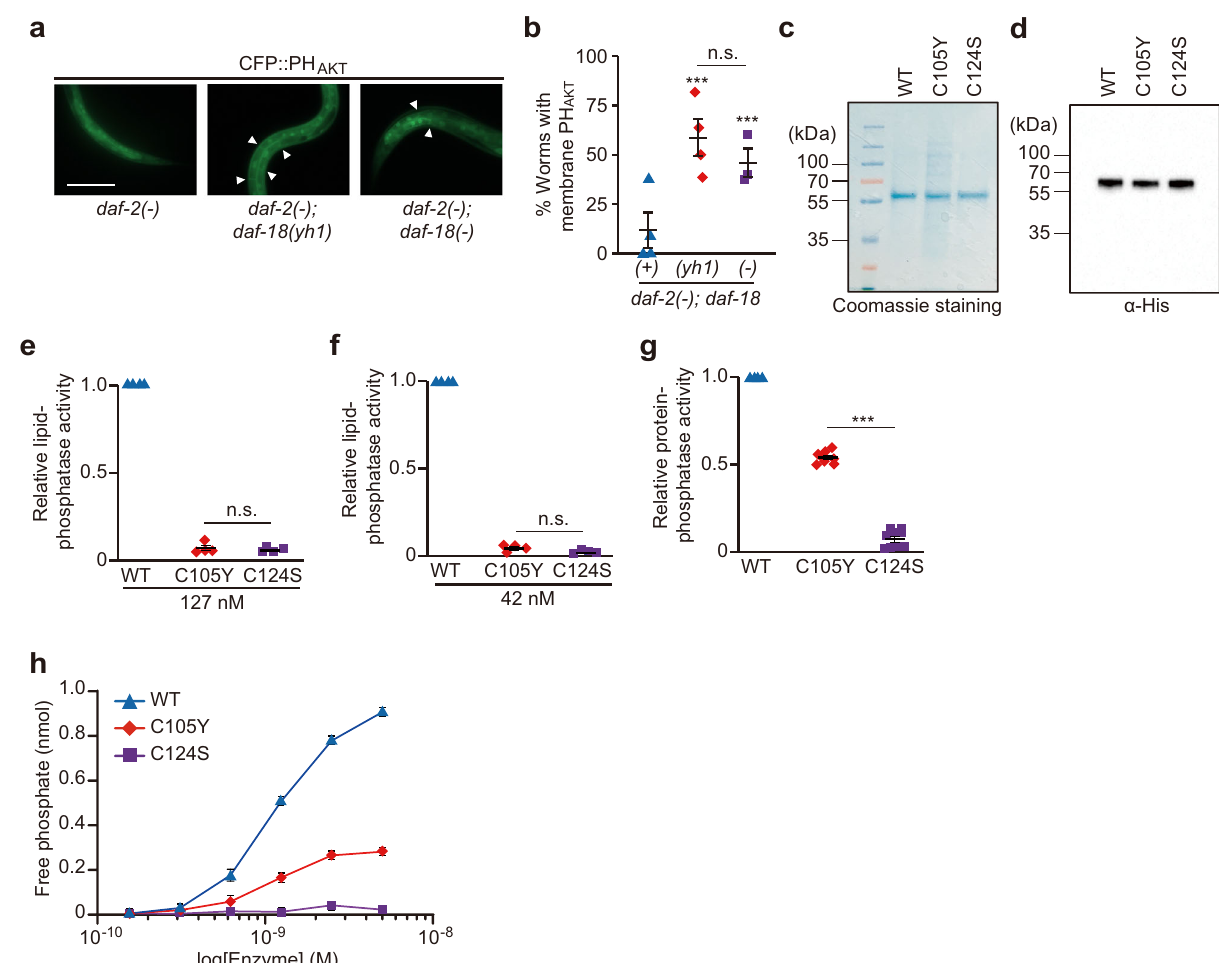
Fig. 3 daf-18(yh1) substantially decreases lipid phosphatase activity, but partially maintains protein phosphatase activity of DAF-18/PTEN. a Representative images of rpl-28p::CFP::PH AKT -expressing worms with daf-2(e1370) [ daf-2( − ) ], daf-2( − ); daf-18(yh1) , or daf-2( − ); daf-18(nr2037) [ daf- 18( − ) ] mutations ( rpl-28p : a promoter of a ubiquitous rpl-28 , ribosomal protein large subunit 28). Scale bar: 50 μ m. Arrowhead: membrane CFP::PH AKT . b Quanti fi cation of membrane-localized PH AKT in worms in panel ( a ) ( n ≥ 23 for each condition, from four independent trials). c , d His-tagged human recombinant PTEN proteins used for in vitro phosphatase assay. WT: wild-type PTEN; C105Y: C105Y mutant PTEN; C124S: C124S mutant PTEN (phosphatase-dead variant). The recombinant proteins were separated by using SDS-PAGE and stained with Coomassie blue ( c ), and detected by using western blotting with anti-His antibody ( d ). e , f In vitro PTEN lipid phosphatase assay. Puri fi ed recombinant WT, C105Y, and C124S PTEN proteins [127 nM ( e ) or 42 nM ( f )] were incubated with PIP 3 substrates ( N = 4). g In vitro PTEN protein tyrosine phosphatase assay. Puri fi ed recombinant WT, C105Y, and C124S PTEN proteins were incubated with phospho-tyrosine-containing peptides, and the protein phosphatase activities were calculated by detecting free phosphates ( N = 9). h Dose-dependent changes in protein phosphatase activities of the PTEN variants ( N = 3). See Supplementary Fig. 4f for the comparison of protein phosphatase activities between WT PTEN and protein tyrosine phosphatase 1B (PTP1B), a positive control. Error bars represent the standard error of the mean (s.e.m., *** p < 0.001, n.s.: not signi fi cant, two-tailed Student ’ s t test relative to WT unless otherwise noted). See Source Data for data points used for the derivation of